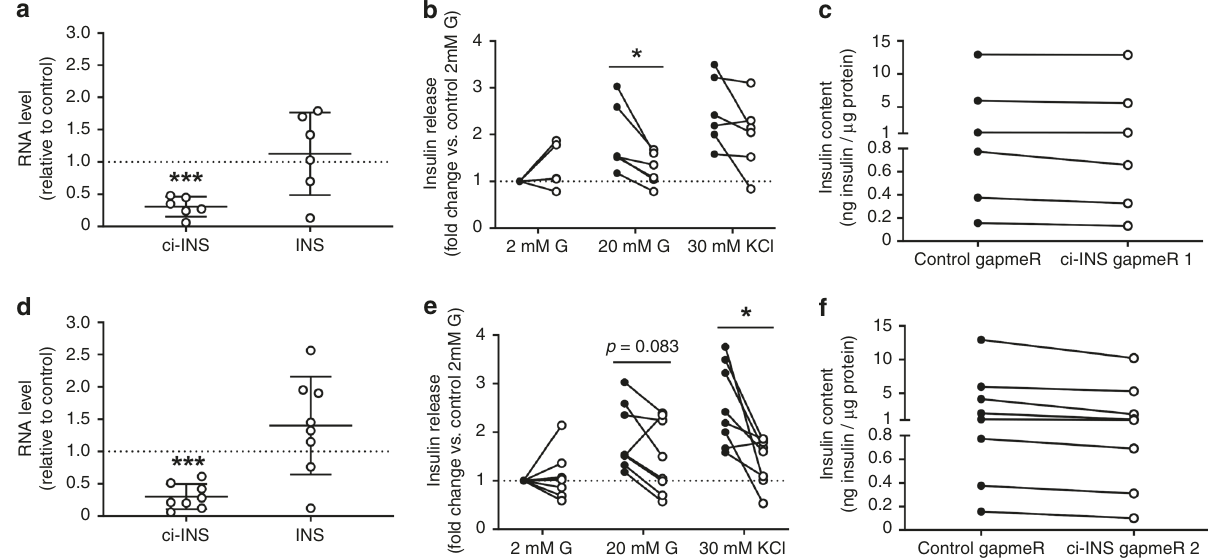
Fig. 5 ci-INS is necessary for ef fi cient human β -cell insulin secretion. a – f Dissociated human islet cells were transfected with control gapmeR (black circles) or with ci-INS (clear circles) gapmeR 1 ( a – c ) or gapmeR 2 ( d – f ). Experiments were performed 48 h after transfection. a , d ci-INS and INS normalized to HPRT1 and PPIA , measured by qPCR, and expressed relative to control in ( a ) ci-INS gapmeR 1 ( n = 6 independent experiments) or ( d ) ci-INS gapmeR 2 ( n = 8 independent experiments). Data and mean are represented ± s.d. *** p = 0.0001 ( a ) and *** p = 0.00002 ( d ) by a two-tailed one-sample t -test. b , e Insulin secretion in response to 2 mM glucose (G), 20 mM G, or 30 mM KCl represented as the fold change vs. control basal (2 mM G) condition in ( b ) ci-INS gapmeR 1 ( n = 6 independent experiments) or ( e ) ci-INS gapmeR 2 (n = 8 independent experiments). * p = 0.018 ( b ) and * p = 0.011 ( e ) by two-tailed paired t -test. c , f Cellular insulin content normalized to protein content in control and ( c ) ci-INS gapmeR 1 ( n = 6 independent experiments) or ( f ) ci-INS gapmeR 2 ( n = 8 independent experiments). Source data are provided as a Source Data fi